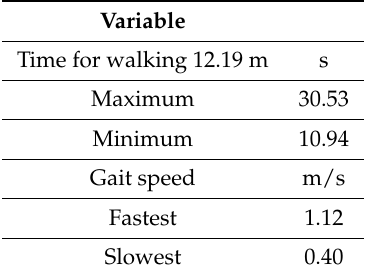
Table 4. Gait peed. n = 16.